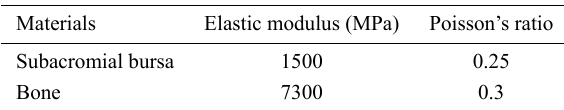
Table 1. Material parameters of the shoulder finite element model.